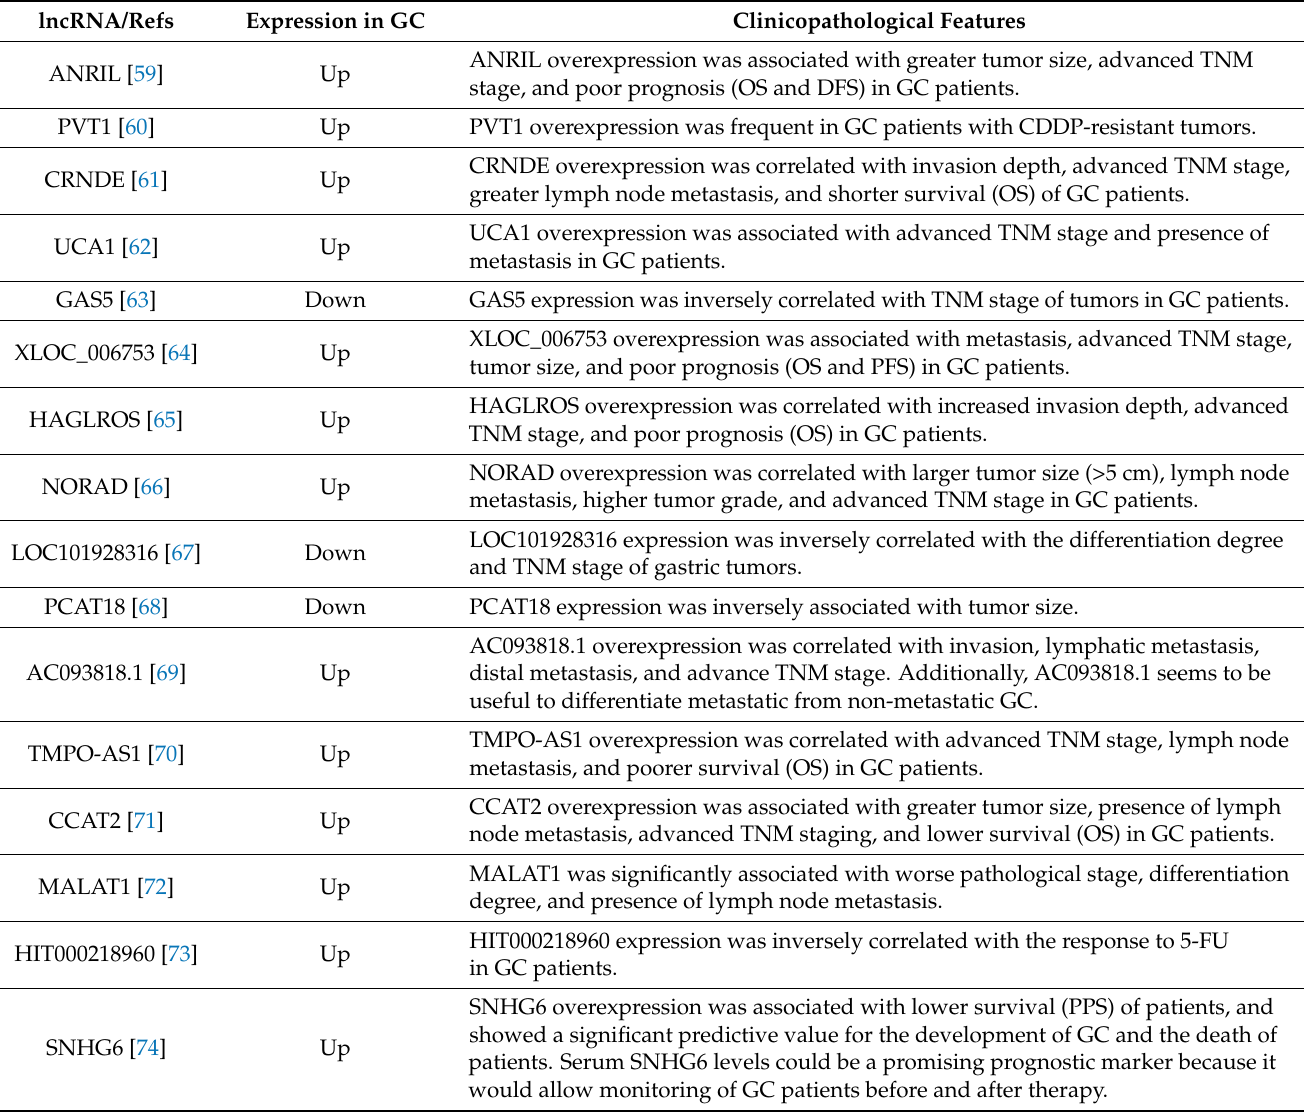
Table 1. Summary of the expression of PI3K/AKT/mTOR pathway-related lncRNAs according to clinicopathological features in gastric